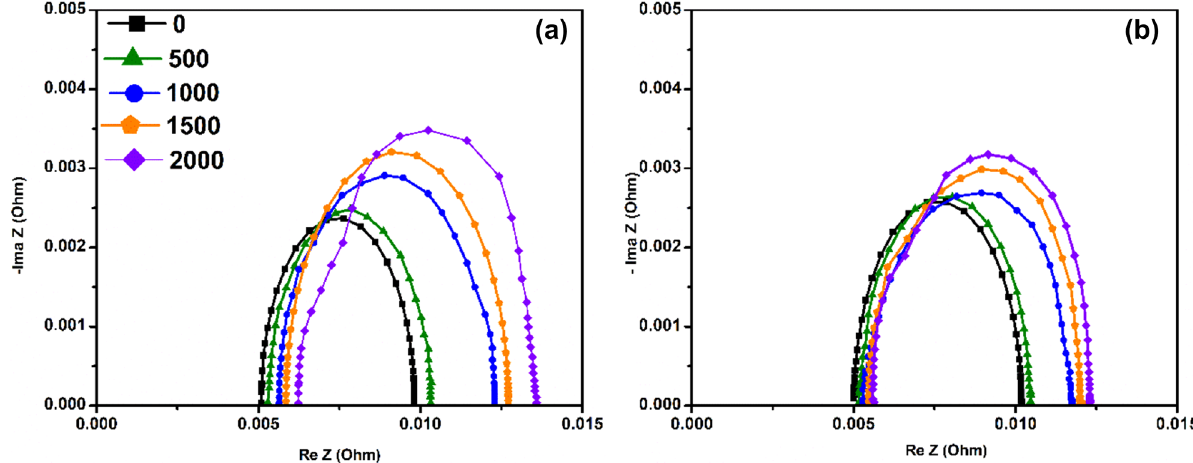
Figure 5. Nyquist plot of ( a ) DLC1 and ( b ) DLC2 for 0, 500, 1000, 1500, and 2000th